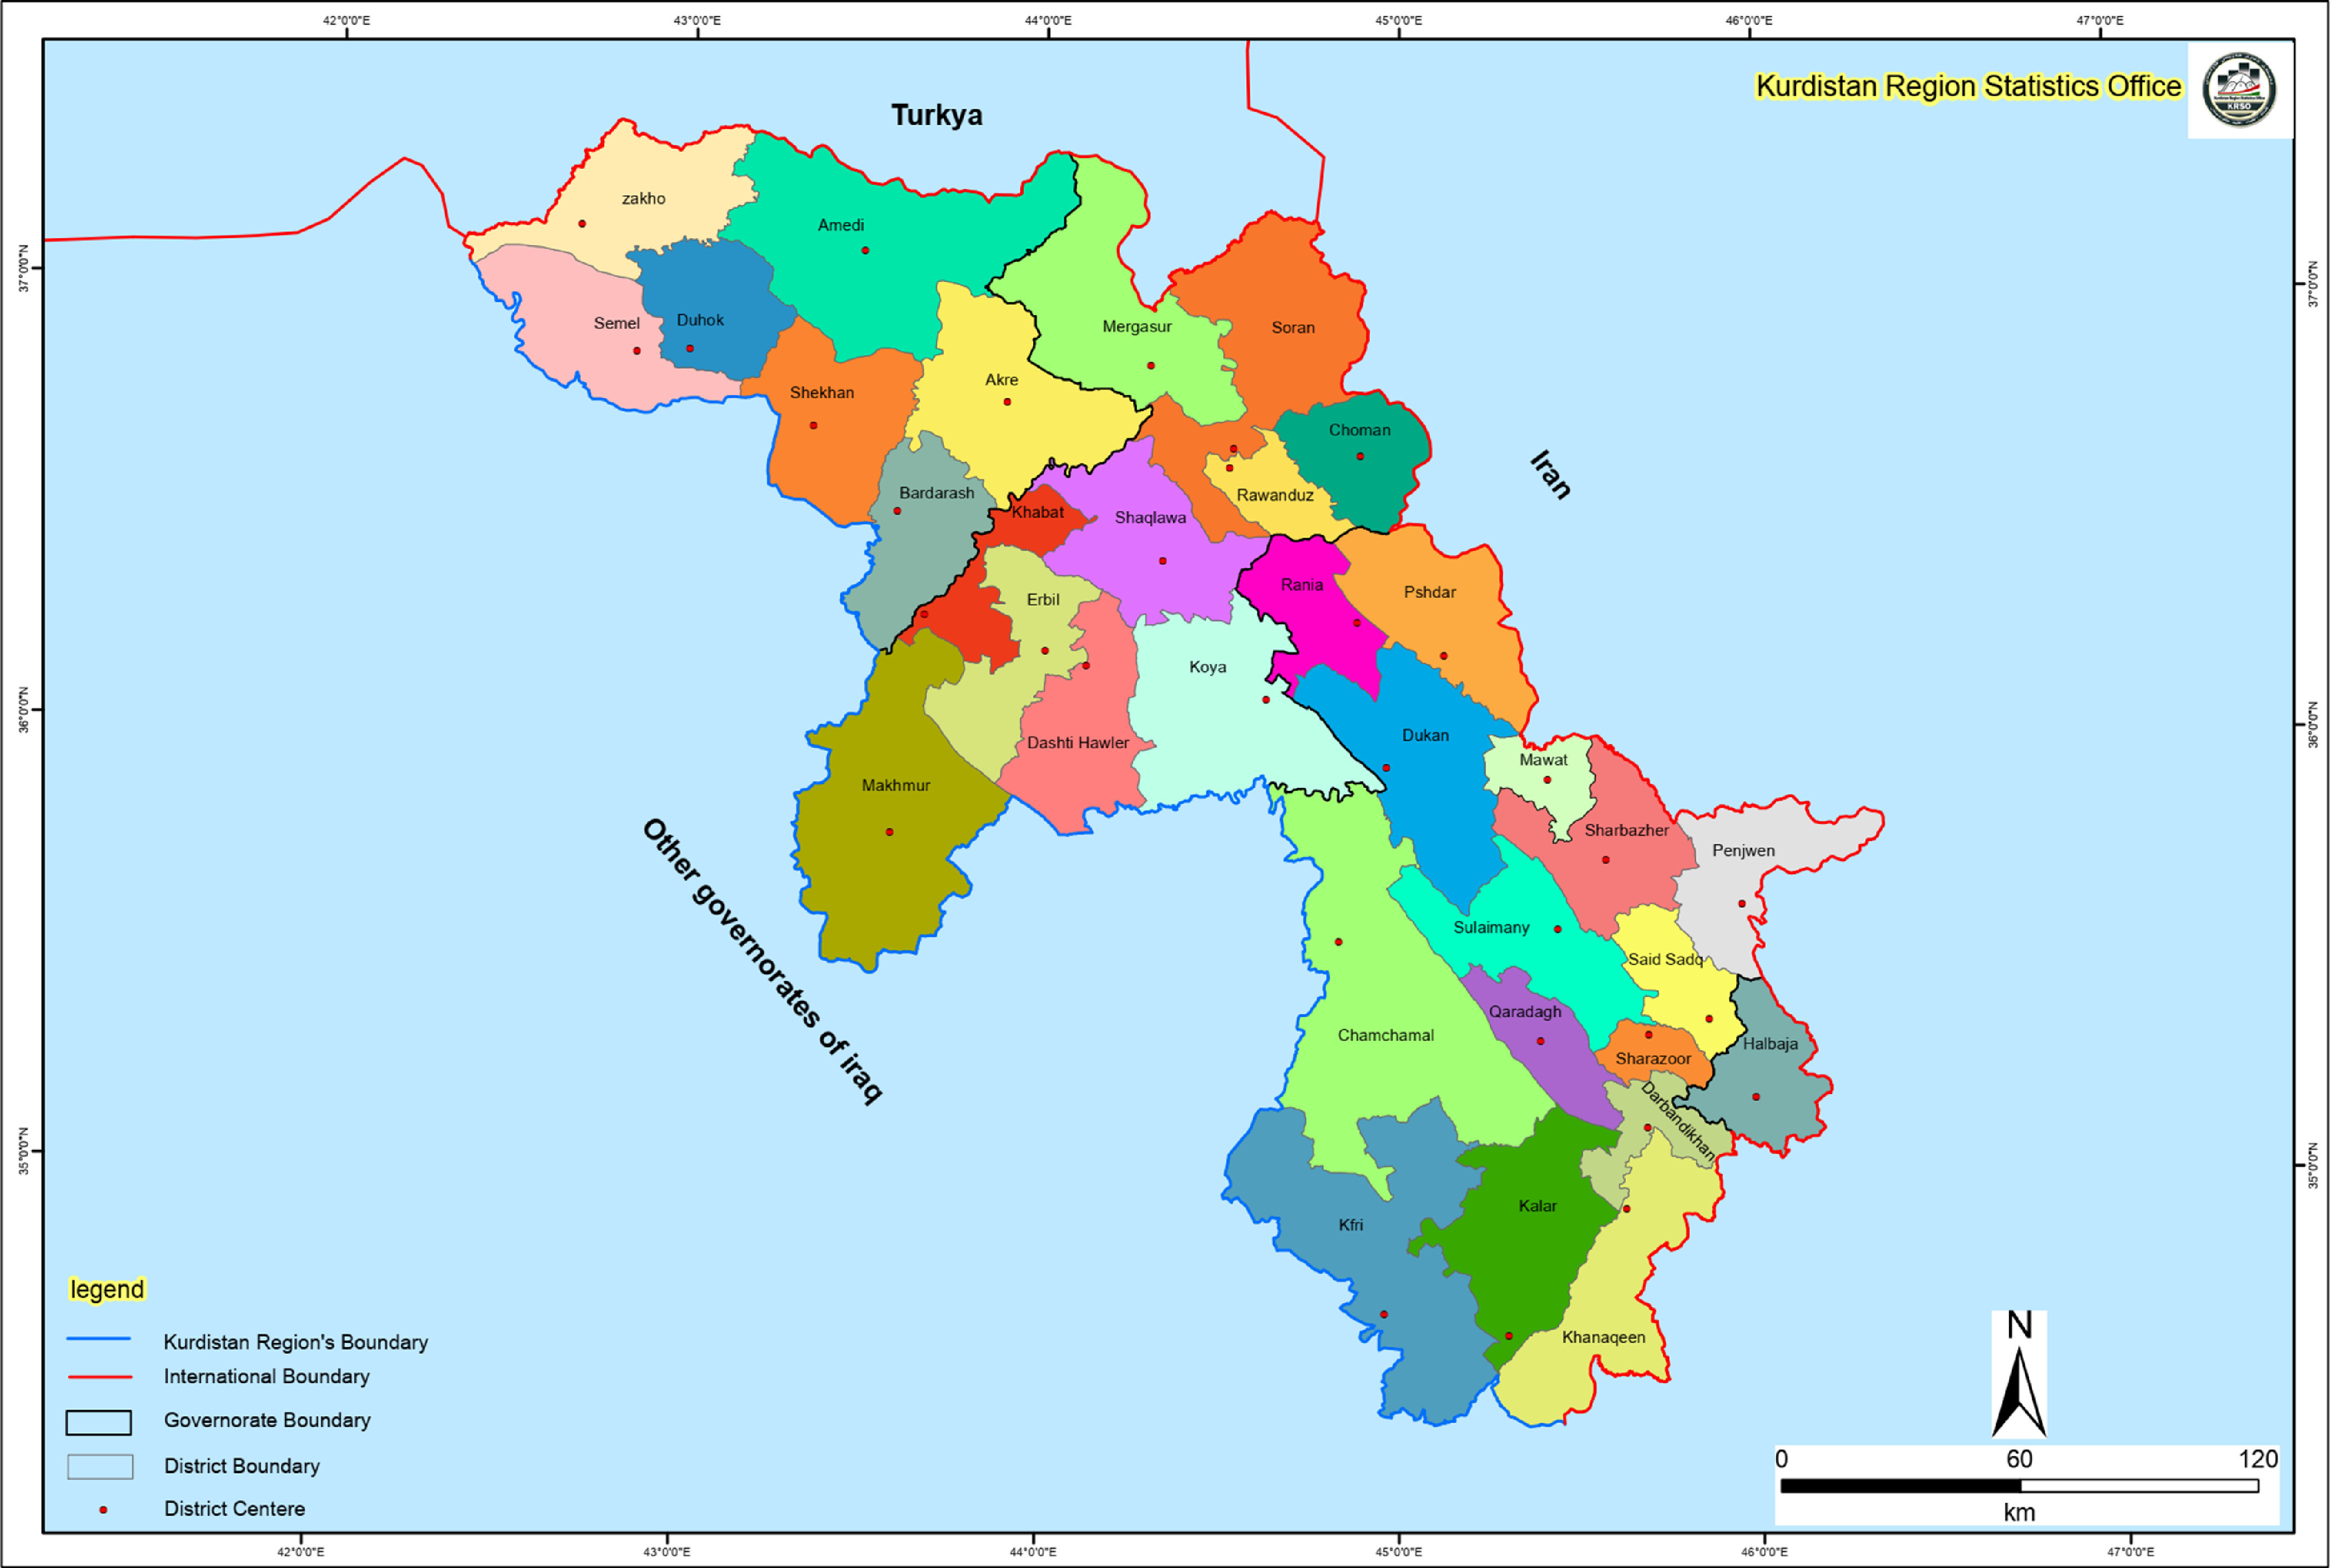
Map of the Districts of Kurdistan Region.8